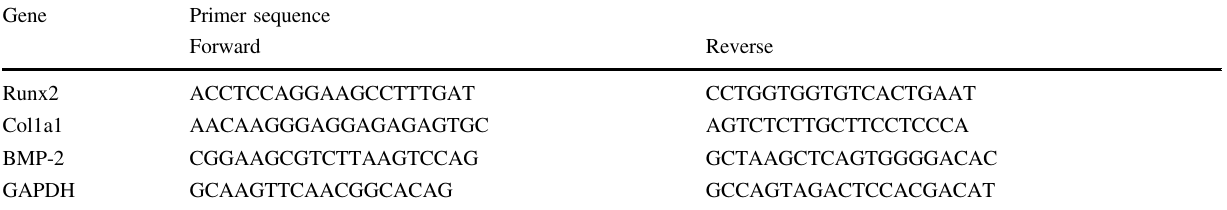
Table 1 Sequences of the primers used in real-time qRT-PCR Gene Primer